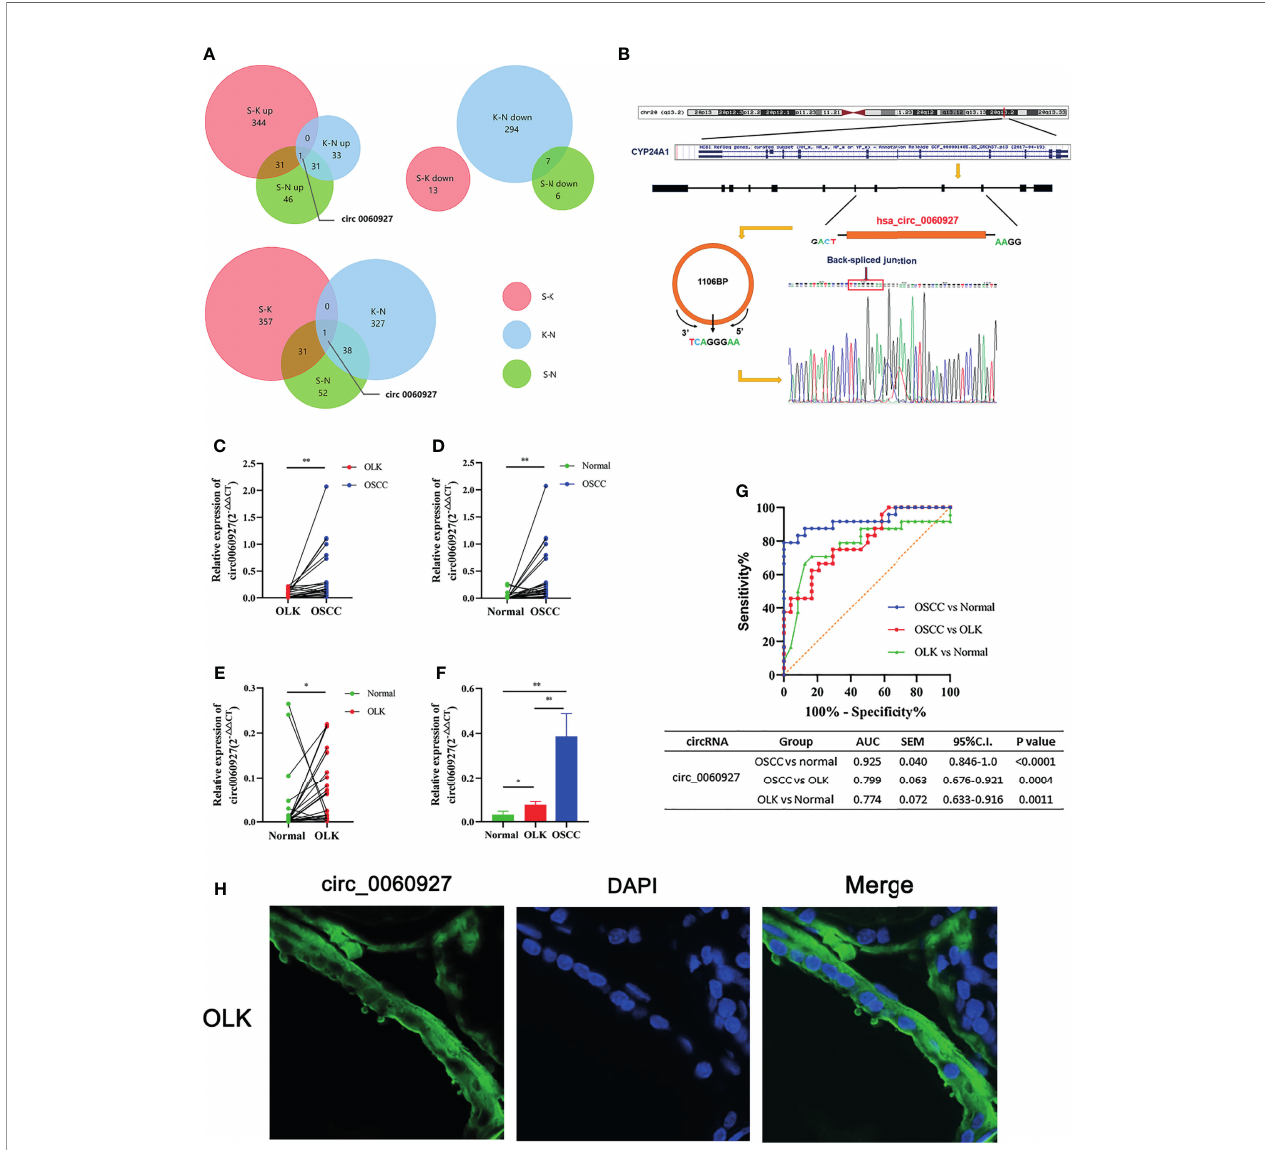
FIGURE 3 | Further validation and visualization analysis of has_circ_0060927. (A) Wynn diagram of differentially expressed circRNAs in OSCC-OLK (S-K), OLK-Normal (K-N), and OSCC-Normal (S-K). Red, S-K; blue, K-N; Green, S-N. (B) The ring formation mechanism and back spliced site of has_circ_0060927. The Sanger sequencing results of circ_0060927 demonstrate that it was a real circRNA with the speci fi c back splice sites (TCAGGGAA). (C) The relative expression in OLK vs. OSCC, (D) normal vs. OSCC, (E) normal vs. OLK, and (F) normal vs. OLK vs. OSCC in the independent cohort with 24 tissues in each group. (* p < 0.05, ** p < 0.01). (G) ROC analysis of circ_0060927 in OSCC vs. normal, OSCC vs. OLK, and OLK vs. normal group. The area under the curve (AUC) showed that circ_0060927 could be a potential diagnosis and prediction biomarker in the OSCC vs. OLK group followed by the OSCC vs. normal group. (H) FISH analysis of